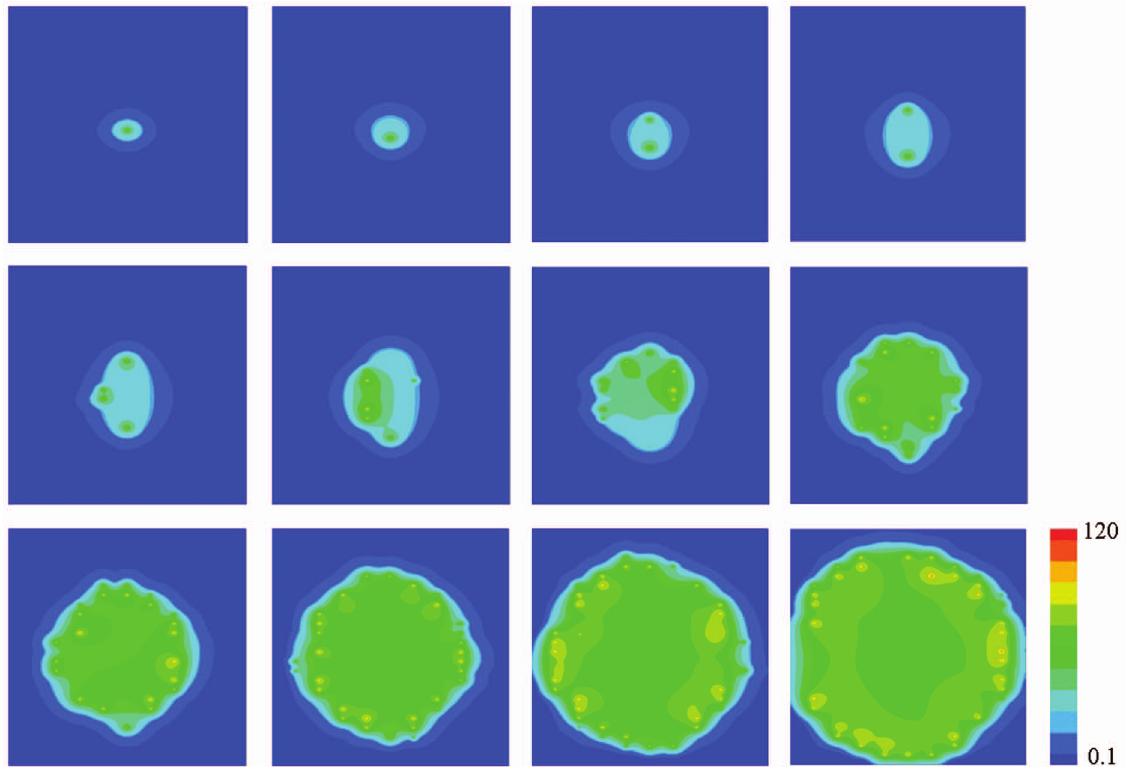
Figure 3. Snapshots of Ca 2 z waves initiating from a 10ms opening of the CRU at the point (10,9.6). Snapshots are taken at 10, 20, 30, 40, 50, 60, 70, 80, 90, 100, 110 and 120ms (left to right, top to bottom). The value of parameters are b ~ 2 : 25 , I CRU ~ 5p A and l x ~ 2 : 0 m m . The concentration is from 0 : 1 m M to 120 m M .